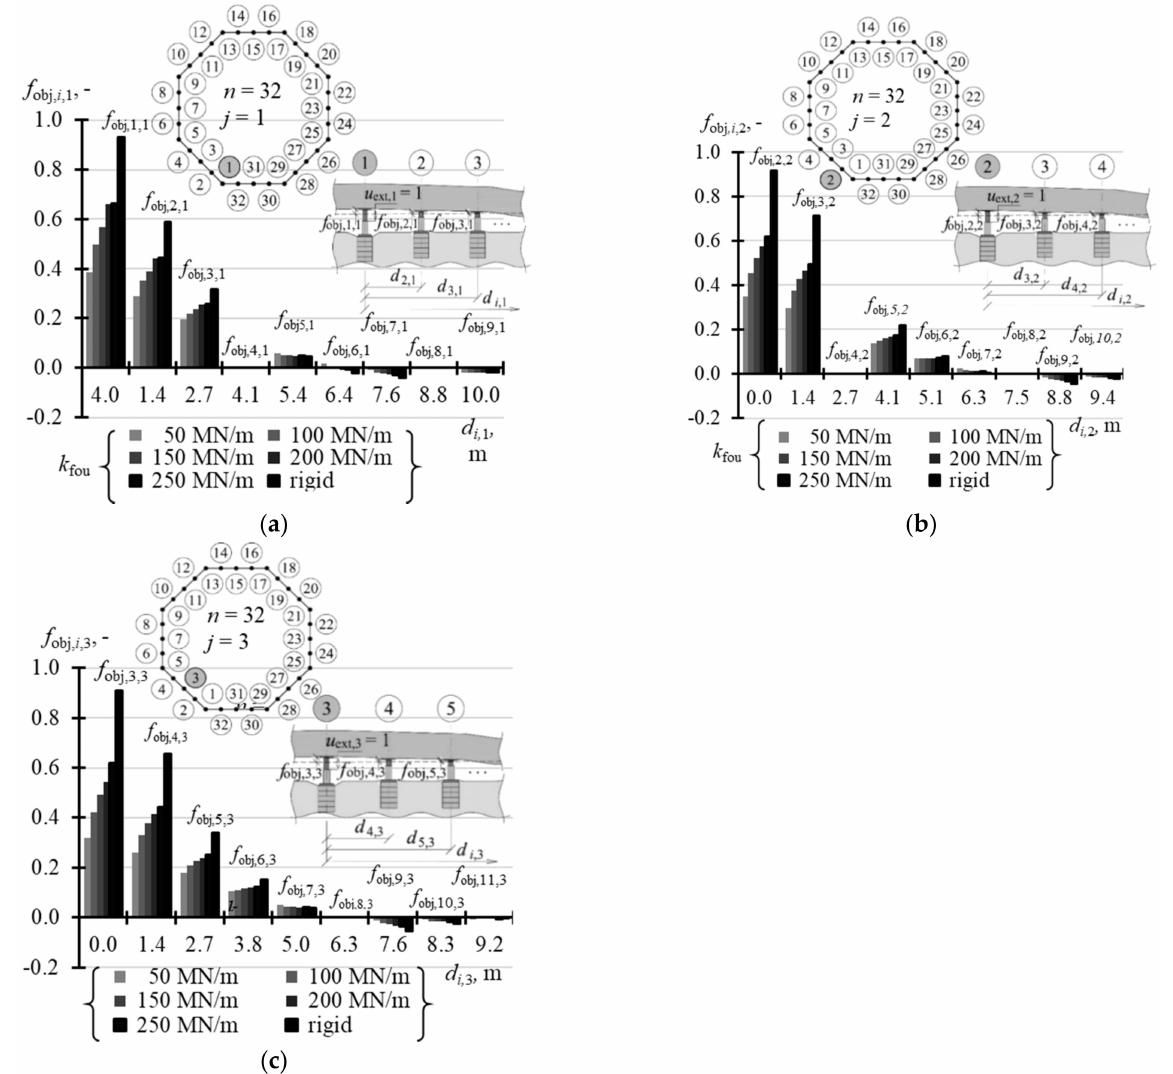
Figure 20. Elements of the matrix f obj for different stiffness values k fou of the jack support when n = 32: ( a ) elements f obj ,i, 1 ; ( b ) elements f obj ,i, 2 ; ( c ) element s f obj ,i, 3